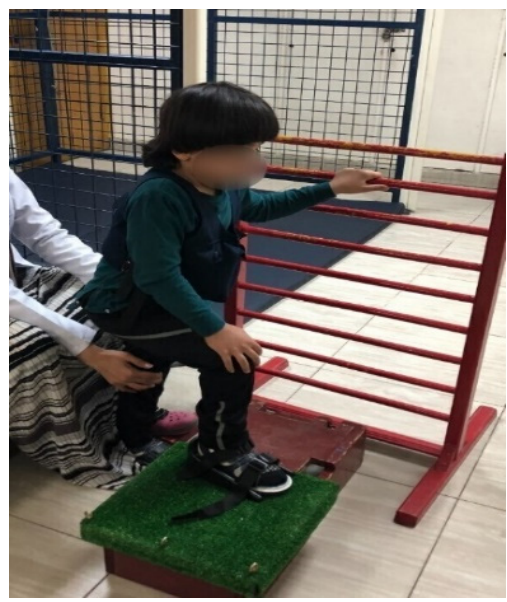
Figure 3. Forward step-up exercise .